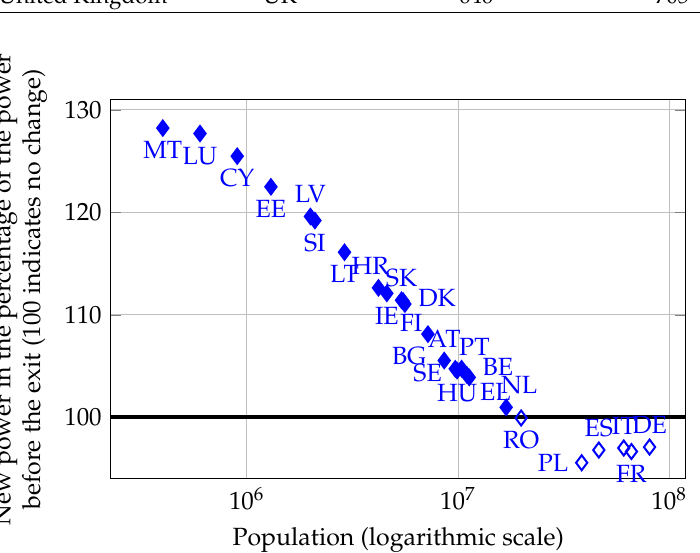
Figure 1. Effect of Czexit with populations for 2015, adjusted Shapley–Shubik